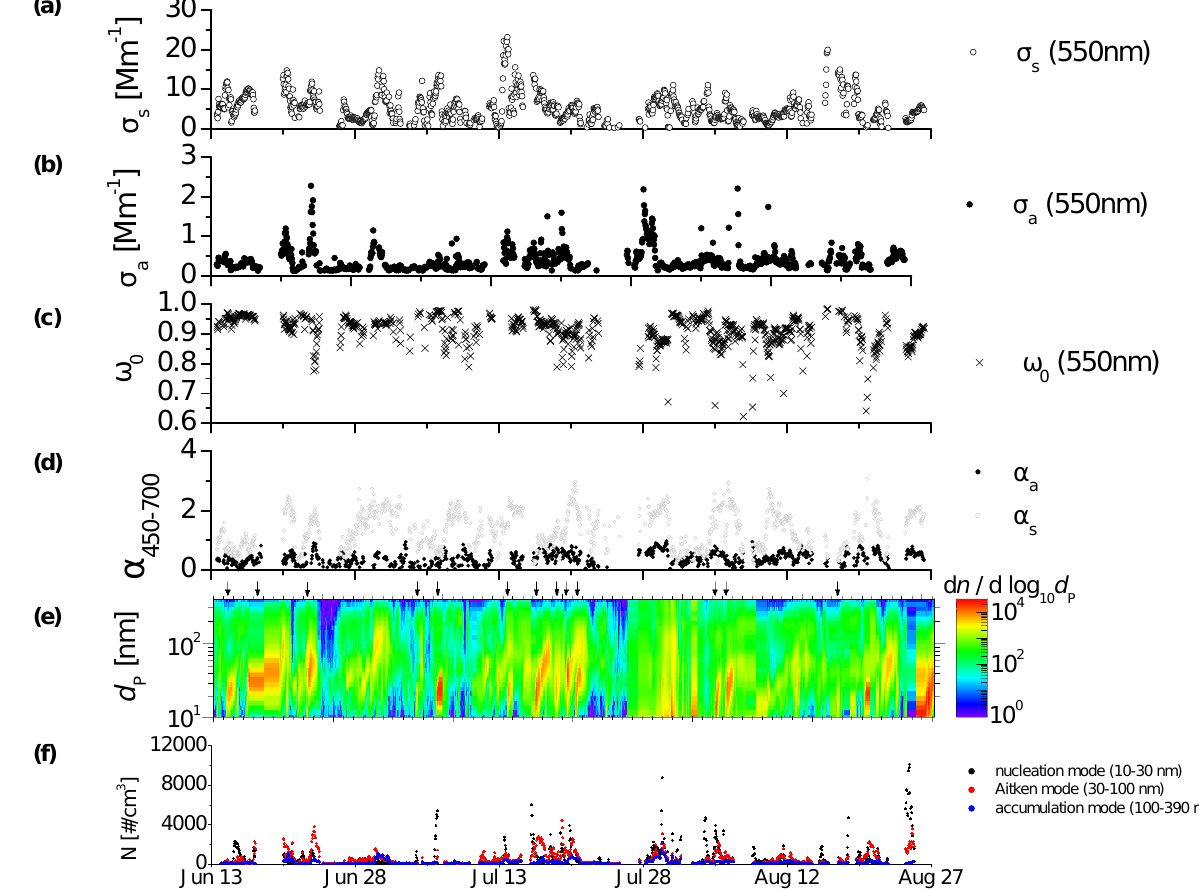
Fig. 2. (a, b, c, d) Time-series of hourly average values of the σ s , σ a , ω 0 , α s and α a . (e) Particle number size distributions measured for the submicrometer particles. Color scale indicates the number of particles in each size. (f) Temporal variation of the concentration of nucleation, Aitken and accumulation modes. The arrows indicate the occurrence of new particle formation events (periods of kind (3) as described in the text). All other concentration increases, not marked with arrows, correspond to periods of type (2). The remaining situations are clean conditions, situation